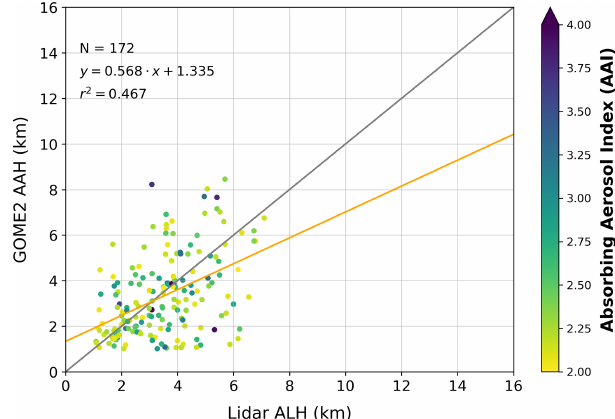
Figure 7. Histogram of absolute differences between GOME-2 AAH and aerosol layer height obtained from EARLINET backscat- ter profiles (using the WCT method), calculated for all collocated cases.